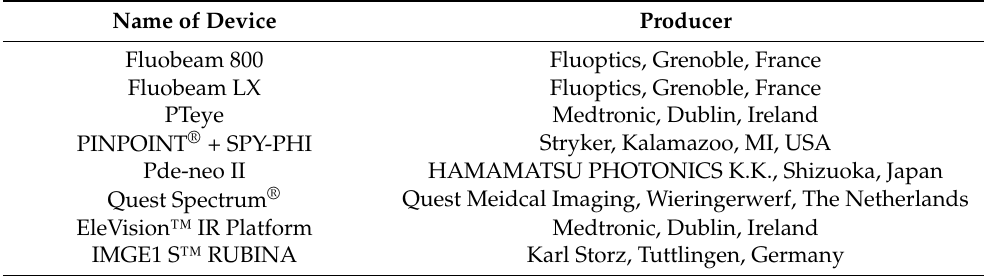
Table 2. Commercially available Near-infrared autofluorescence